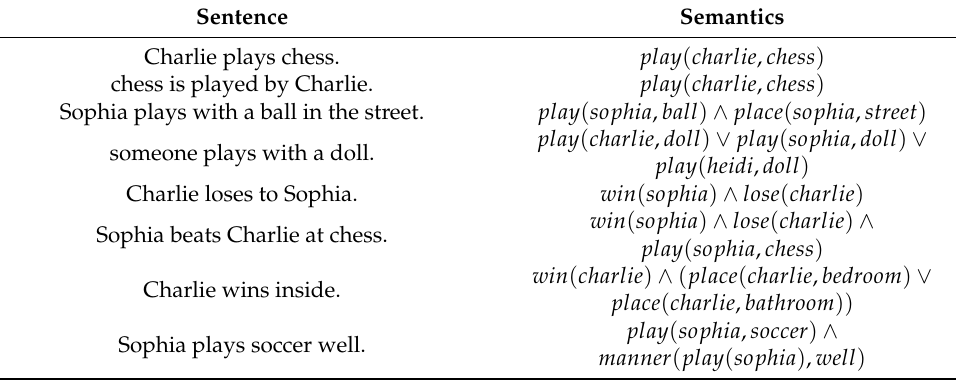
Table 3. Examples of sentences generated with the microlanguage, paired with the propositional logic form of the described